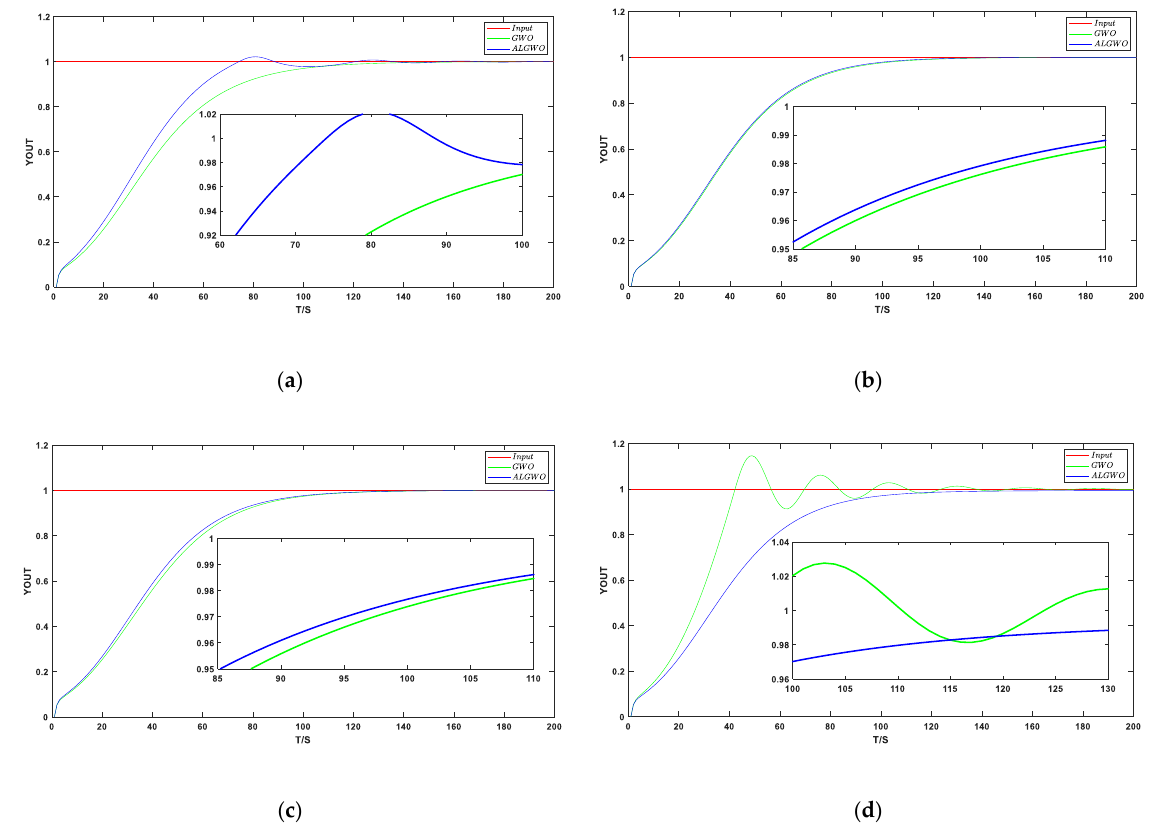
Figure 14. The step response results on test system 6. ( a ) The simulation results of BPNN-PID using g ( x ) and ( b ) simulation results of BPNN-PID using t ( x ) and ( c ) simulation results of BPNN-PID using h ( x ) and ( d ) simulation results of traditional PID.